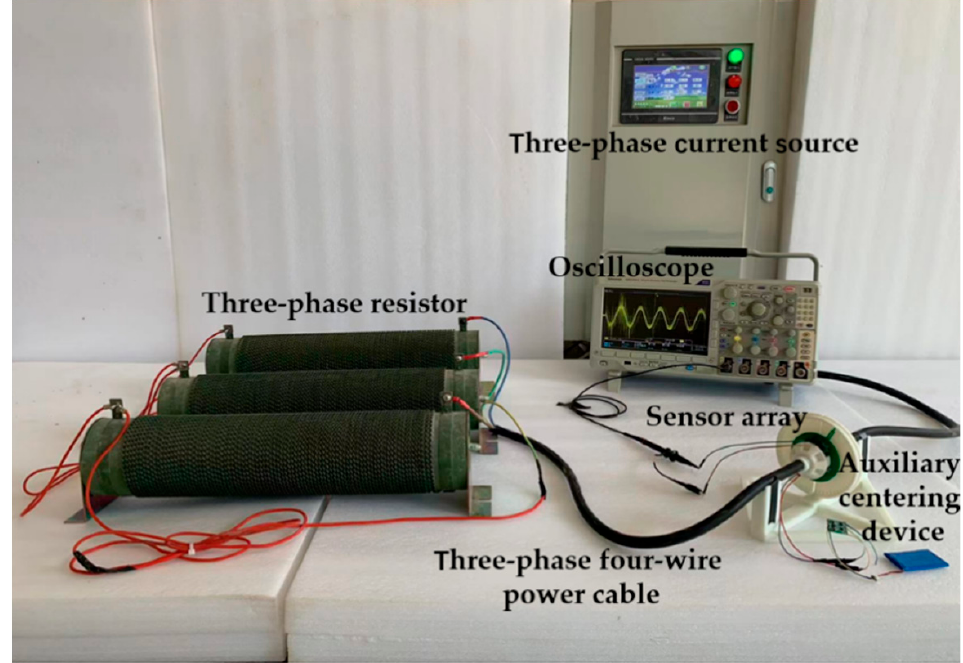
Figure 9. Physical diagram of the magnetic field strength distribution experiment.